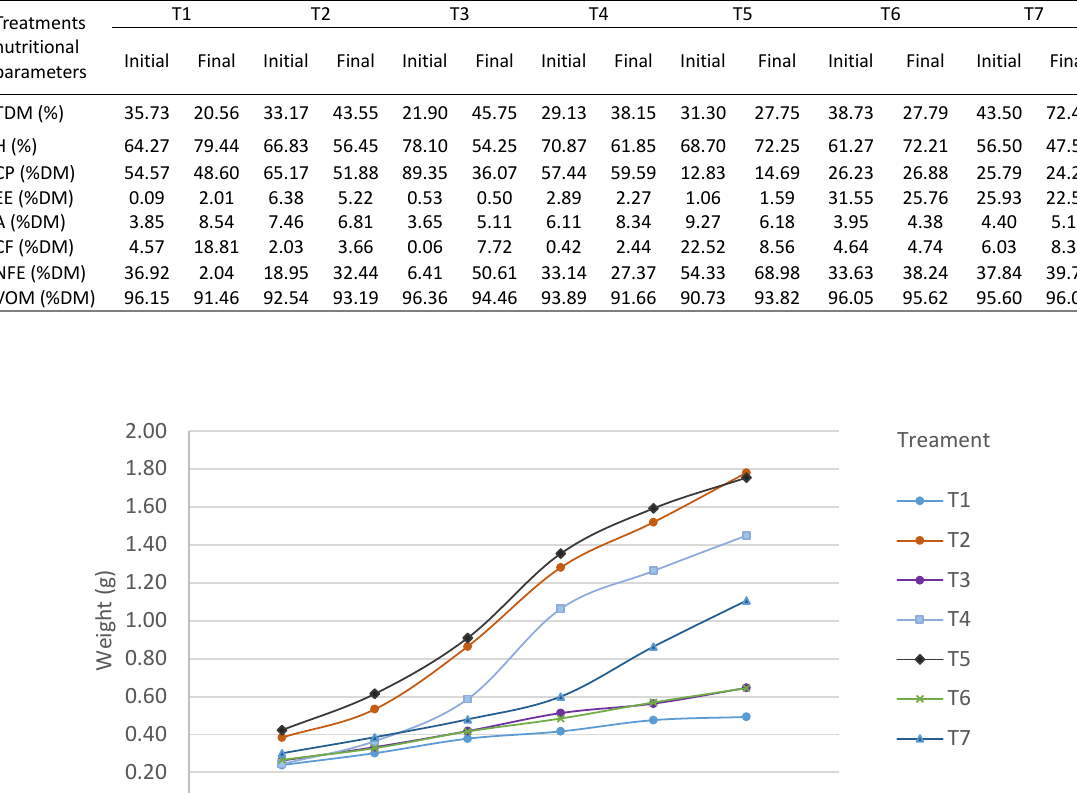
Table 1: Comparison of initial and final nutritional parameters for each of the seven different treatments